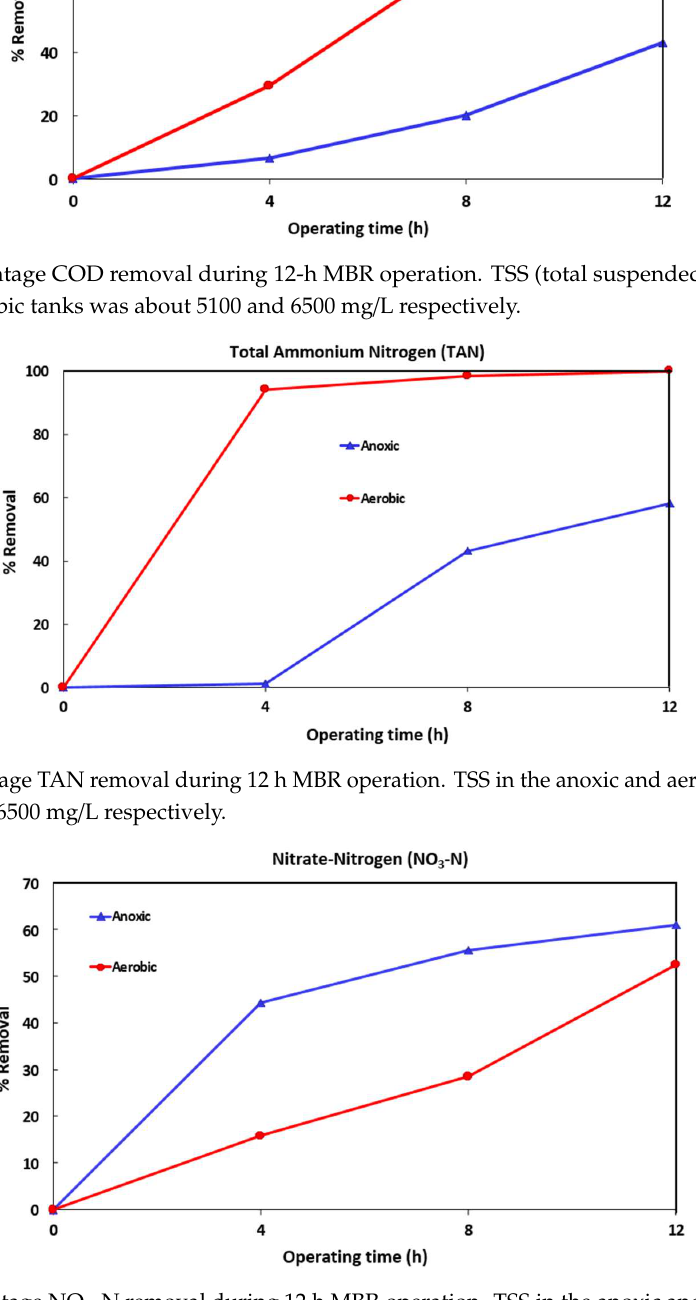
Figure 4. Percentage NO 3 -N removal during 12 h MBR operation. TSS in the anoxic and aerobic tanks was about 5100 and 6500 mg / L